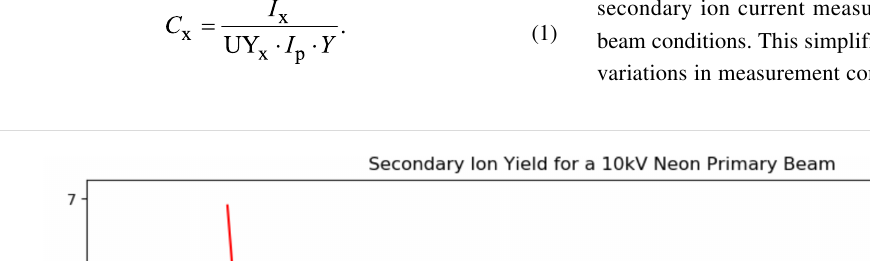
polish smooth as lapping cloths do. As a result, it is almost impossible to satisfy both requirements. The